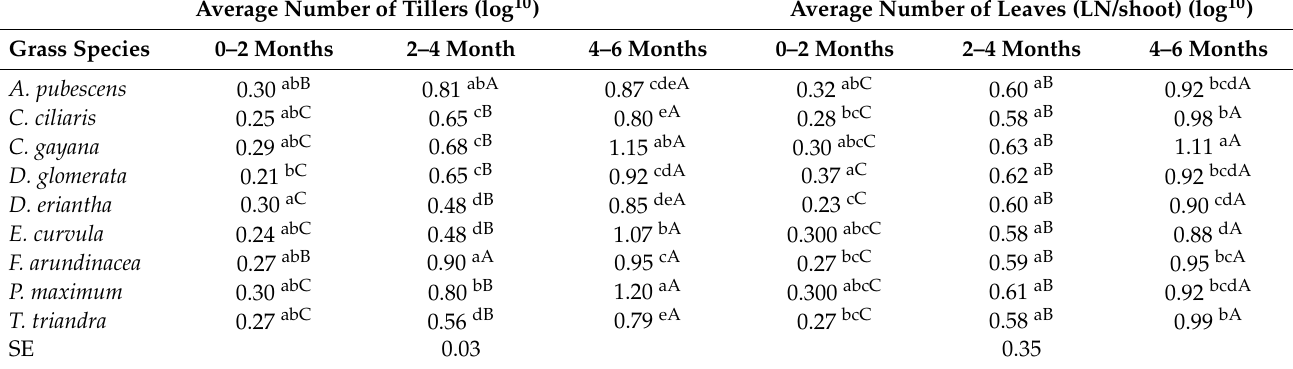
Table 2. Effect of grass species and age on the average number of tillers and leaves (LN/shoot) and tillers (log 10 ) of nine selected grass species grown under controlled